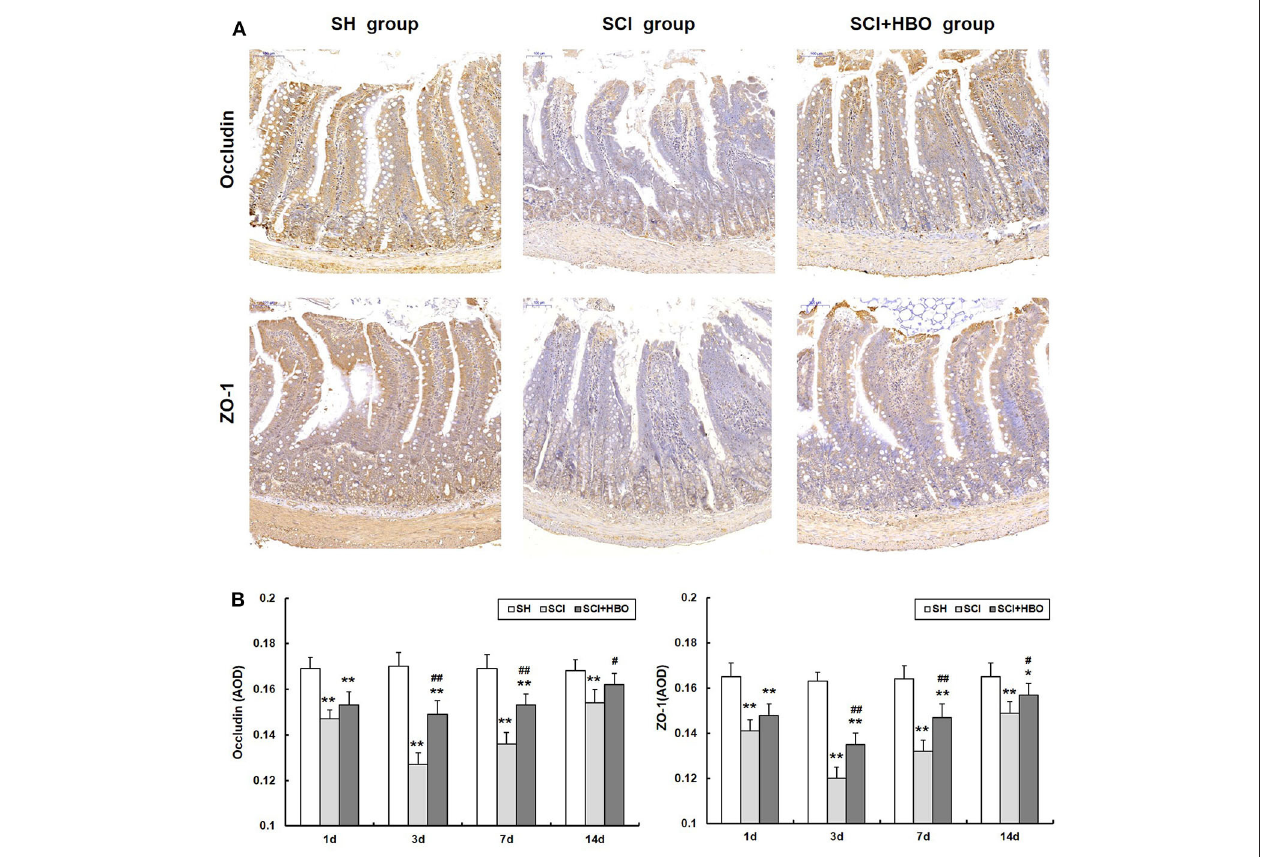
FIGURE 3 | Effect of HBO on occludin and ZO-1 immunoreactivity in jejunum tissue after SCI. (A) Expressions of occludin and ZO-1 in the jejunum tissue visualized by immunohistochemistry under a high magnification on postoperative day 3 (all images are × 200 magnification, bar = 100 µ m). (B) Analysis of the average optical density of occludin and ZO-1. Data are presented as mean ± SD. Compared with the SH group, the average optical density of two factors significantly decreased after SCI (* P < 0.05, ** P < 0.01); HBO exposure significantly increased the average optical density of occludin and ZO-1 compared with the SCI group ( # P < 0.05, ## P < 0.01). HBO, hyperbaric oxygen; SCI, spinal cord injury.